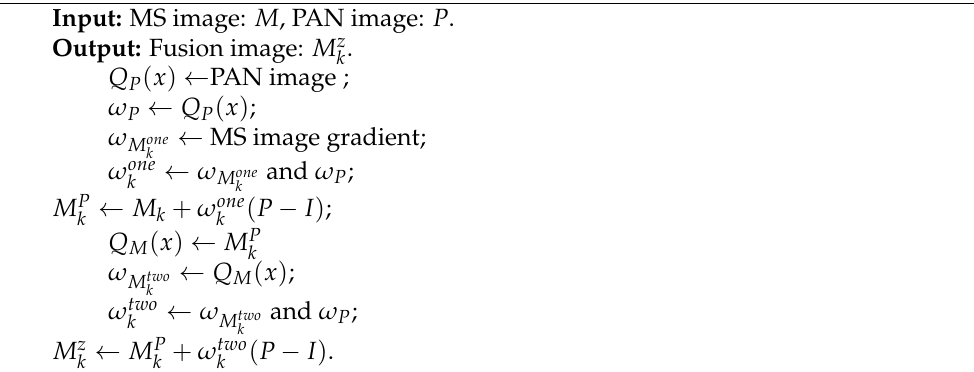
Algorithm 1: GIAIHS algorithm. Proposed algorithm for two-stage